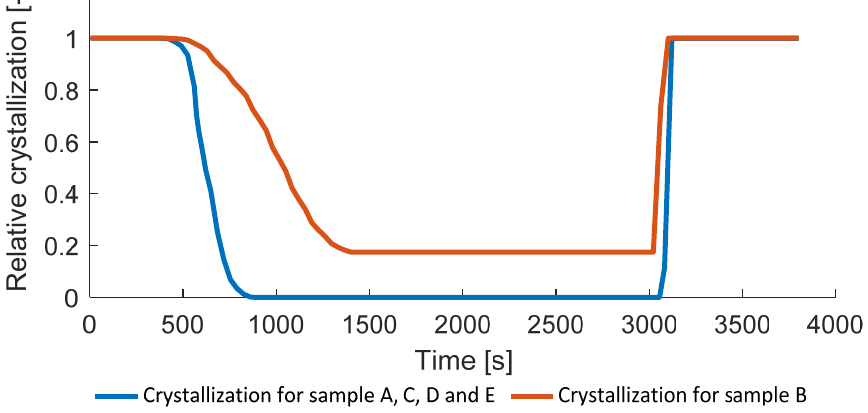
Figure 13. Relative degree of crystallization.